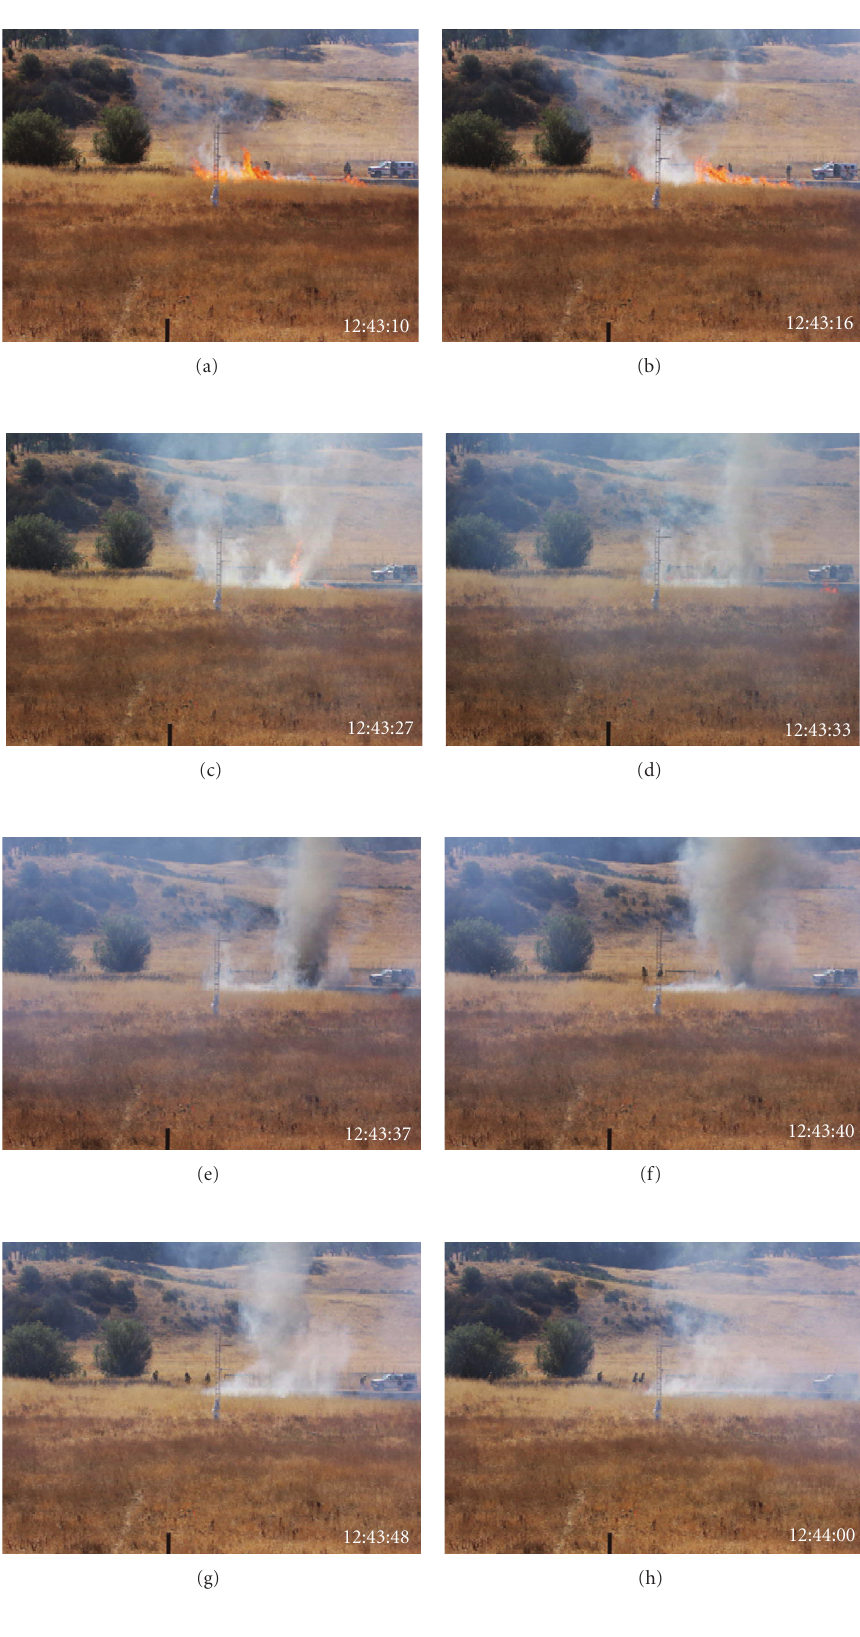
Figure 6: Time-lapse photographs of the fire whirl evolution during a valley wind reversal. Times are indicated in the bottom of each panel in